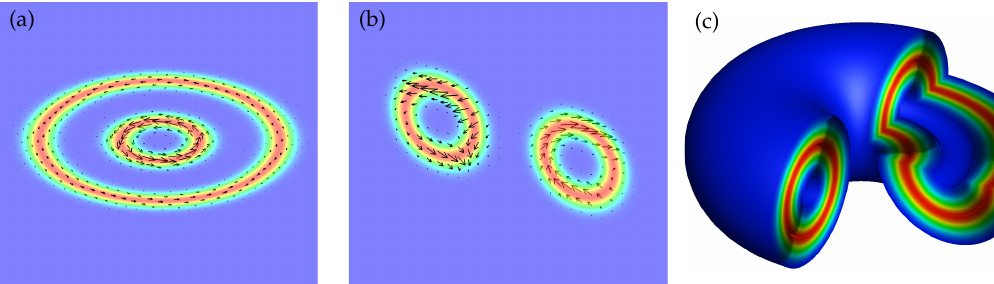
Figure 10. ( a ) xy - and ( b ) yz -cross-sections, and ( c ) isosurface of the energy density of a linearly polarized toroidal wavepacket with orbital angular momentum directed to the positive z